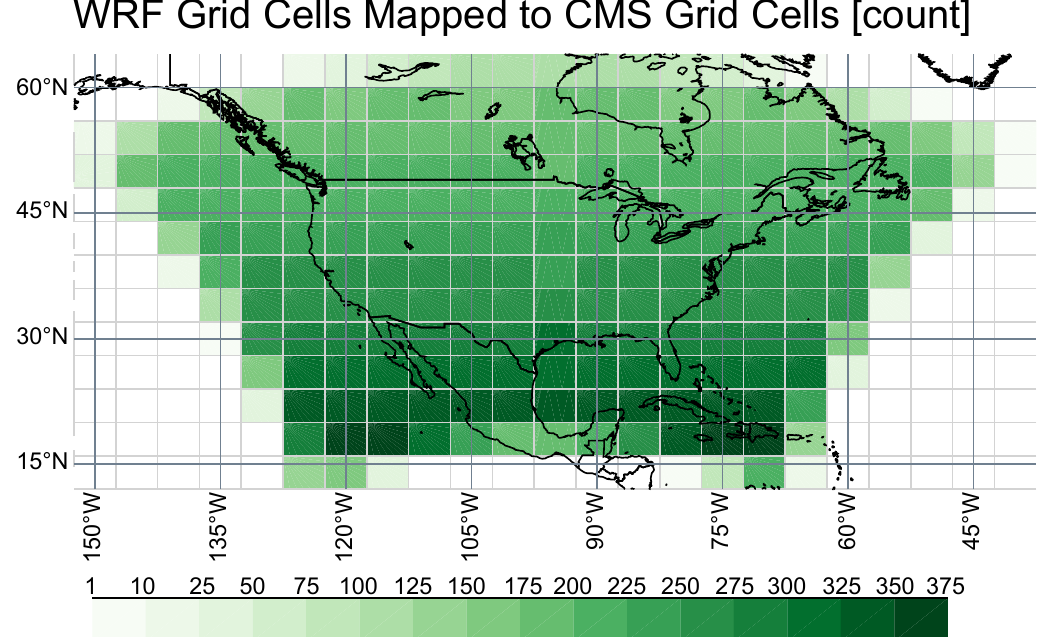
Figure A2. Mapping of the WRF North American domain to the CMS-Flux GEOS-Chem grid. Light gray lines indicate the boundaries of the GEOS-Chem grid cells. Shading indicates the number of WRF grid cells assigned to each GEOS-Chem grid